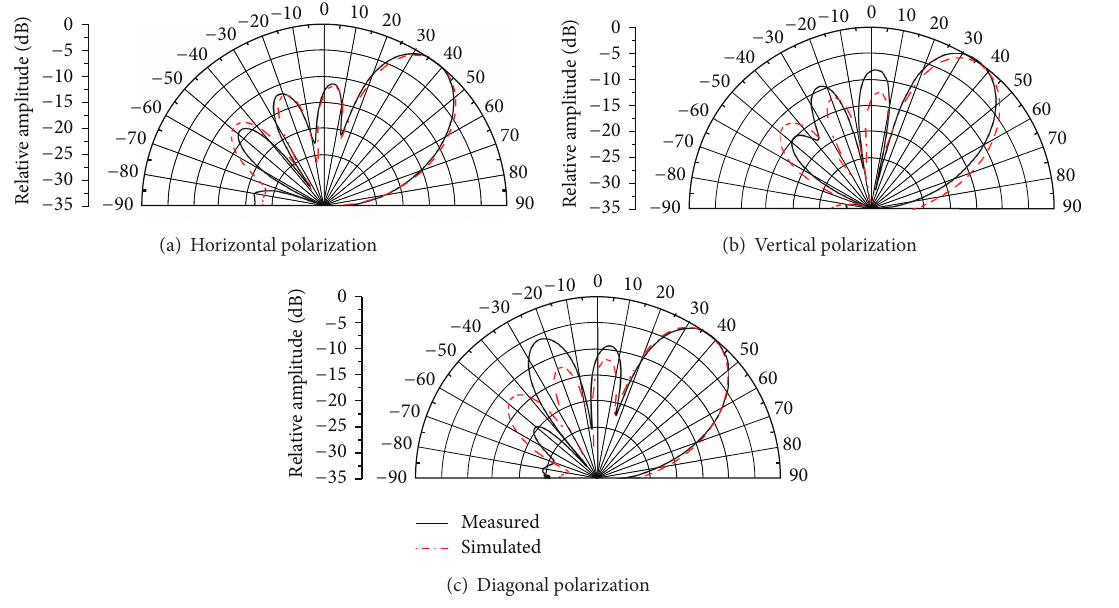
Figure 18: The polarization tracking patterns measured at 12.5 GHz with beam scanned to 40 ∘ .